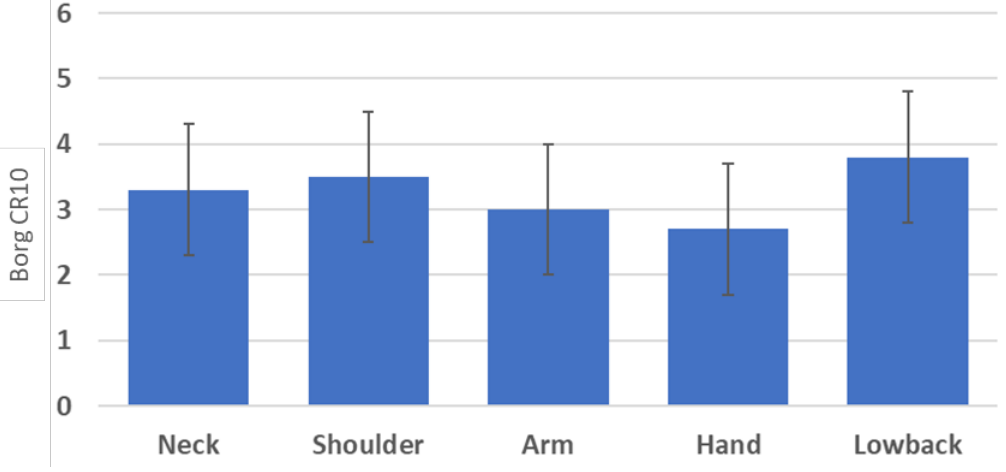
Figure 6. Subjective workload rating (Borg CR10).